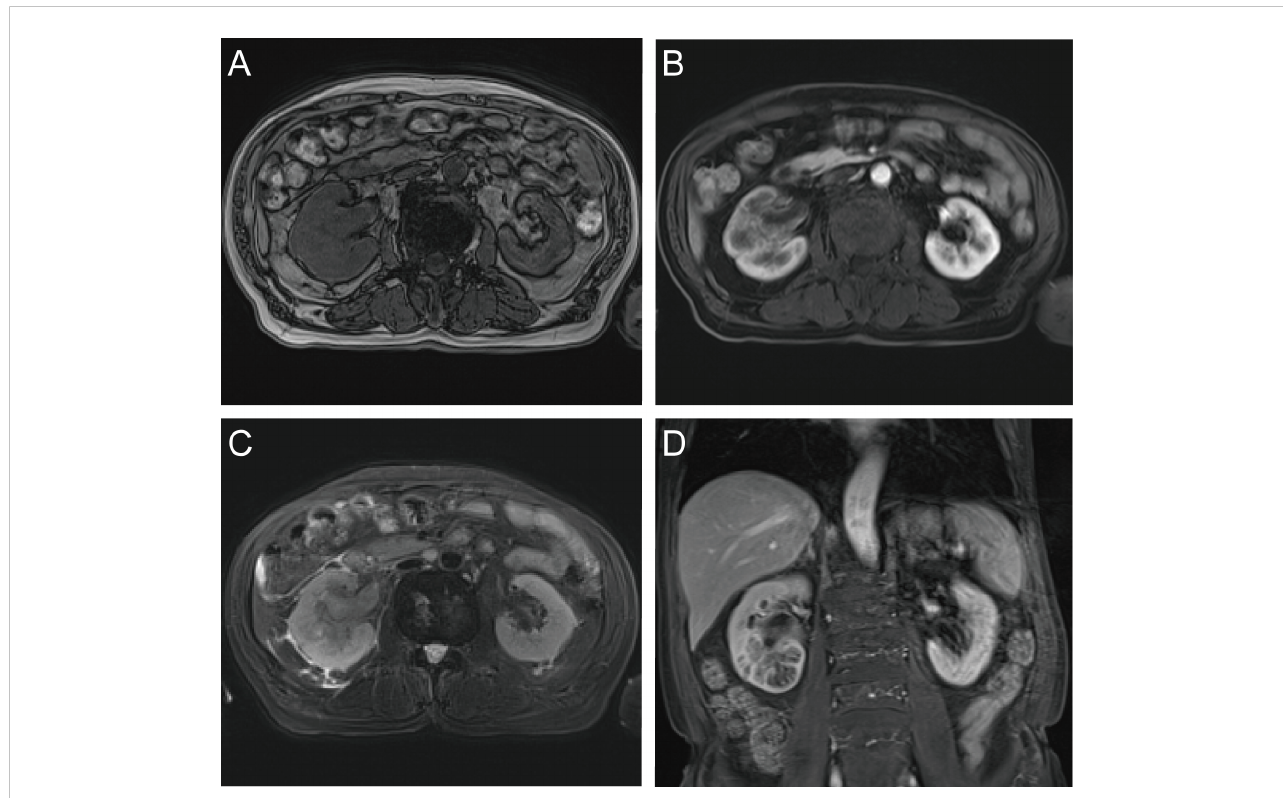
FIGURE 1 Enhanced MRI examination. (A) axial T1-weighted imging; (B) axial T1-weighted arterial phase imaging; (C) axial T2-weighted imging; (D) coronal T1- weighted arterial phase